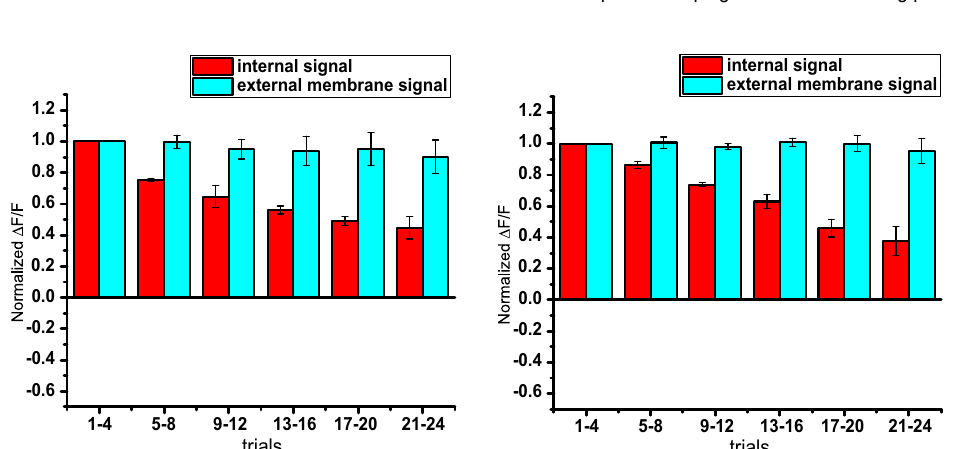
Figure 5. The signal size during repeated patch clamp measurements. ( A ) Normalized internal and external membrane optical signal size for different trials in response to the 100 mV step. HEK239 cells expressing Aahn were voltage-clamped directly. ( B ) Normalized internal and external membrane optical signal size in response to the 100 mV step. HEK239 cells expressing Aahn were voltage-clamped indirectly. ( C ) Normalized internal and external membrane optical signal size in response to 50 mV steps. HEK239 cells expressing Aahn were voltage-clamped indirectly. ( D ) Normalized internal and external membrane optical signal size in response to the 100 mV step with a − 35 mV holding potential. HEK239 cells expressing Aahn were voltage-clamped indirectly. The error bars represent the standard error of the mean (n = 3 cells for each